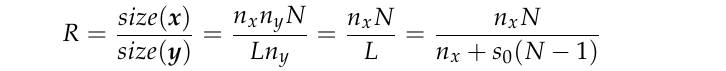
Figure 10. Line chart of SSIM of the reconstruction results of PnP-FFDNet and PnP-BM3D when the number of CUP compressed frames increases.